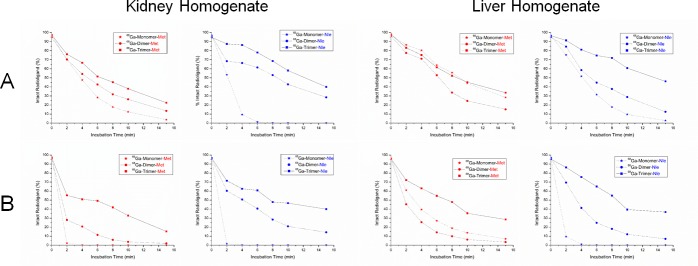
In vitro stability assessment of radiopeptides in rat organ homogenates.68Ga-labelled mono- and multimeric peptide conjugates incubated with varying concentrations, 1% (A) and 10% (B) respectively, of rat kidney and liver homogenates. Data are presented as mean (n = 2), error bars omitted.